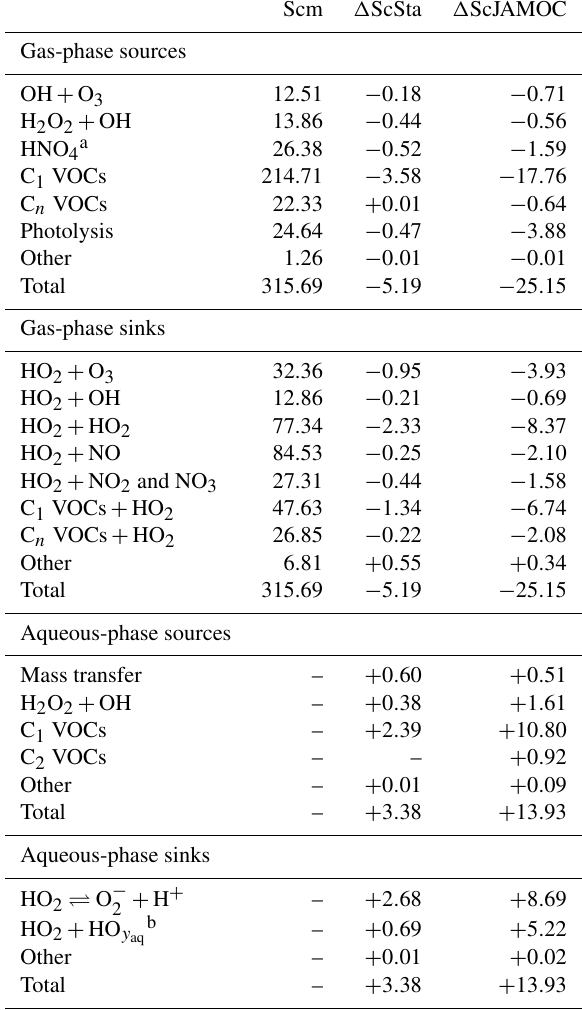
HO 2 . For ScJAMOC, the chemical production decreases by Table 4. Global tropospheric mean gas- and aqueous-phase source and sink fluxes of HO 2 for Scm and the changes induced by ScSta about 150 Tgyr − 1 (2.6 %), mainly caused by an overall re- and ScJAMOC. The characteristics of each simulation are provided duction in HO 2 (see Sect. 4.2) and in RO 2 radicals due to in Table 1. All values are given in Tmolyr − 1 . The aqueous-phase the uptake and explicit oxidation of VOCs. The chemical budget is only based on cloud droplets. Rain droplets are not taken loss on the other hand is reduced by about 90 (1.7 %) and into account. tively. This reduction is mainly attributed to an overall Scm (cid:49) ScSta